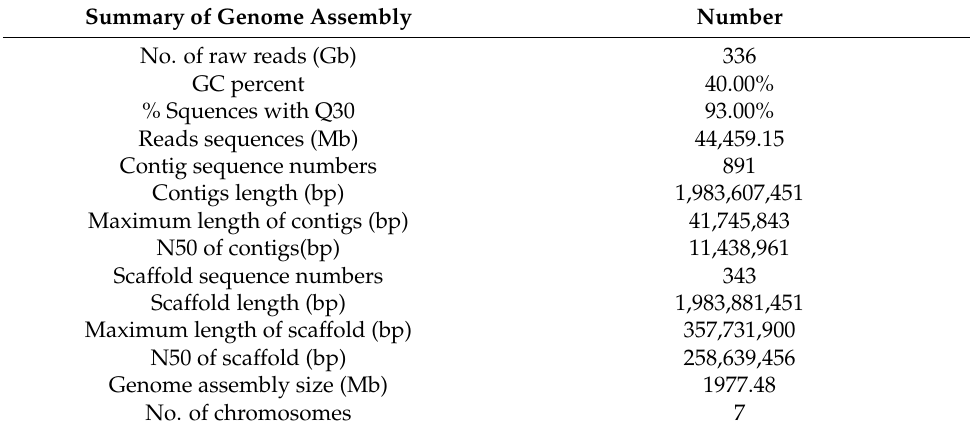
Table 1. Summary of sequencing and assembly results of M. incana genome